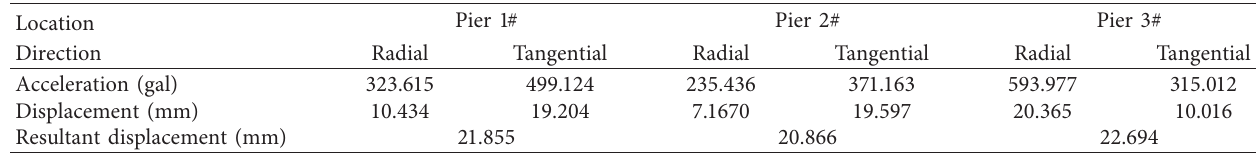
Table 3: Peak value of acceleration and displacement response of each pier.